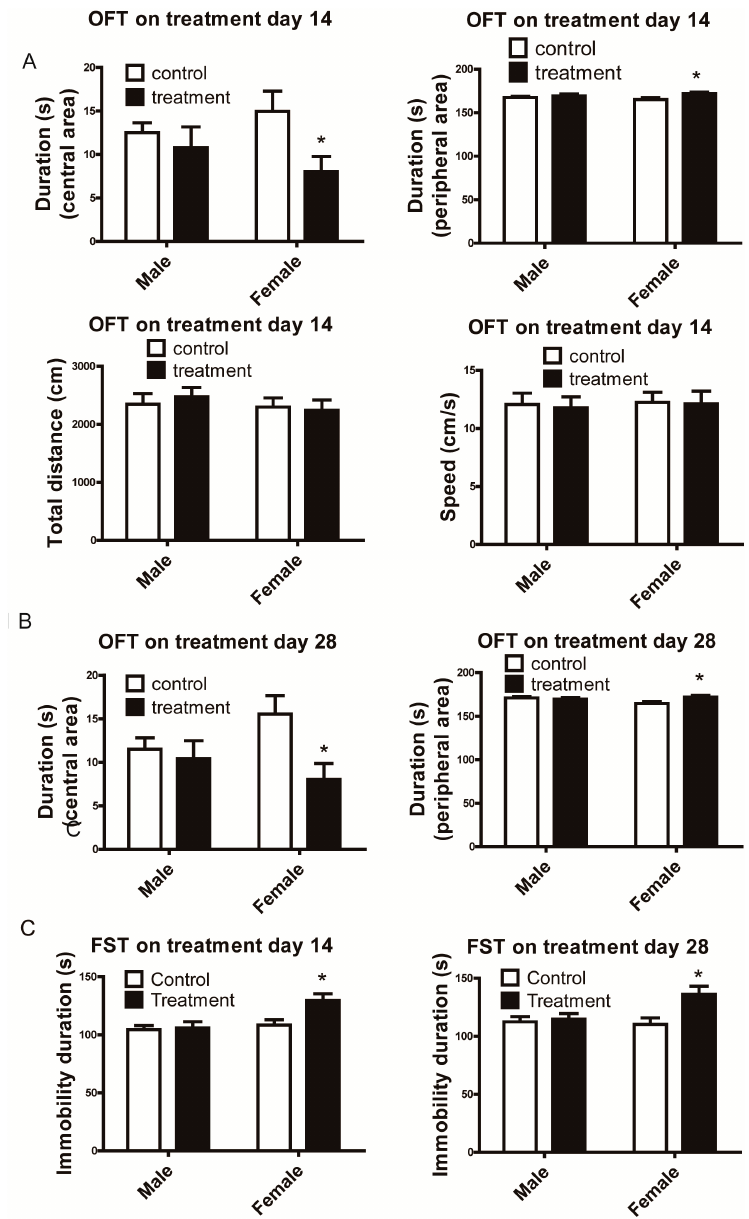
Figure 1. Emotional behavioral tests of mice treated by Al 2 O 3 NPs. ( A ): female mice showed less duration in central zone and increased duration in periphery zone in OFT on treatment day 14, ( B ): On the treatment day 28, results were consistent with day 14, ( C ): female mice showed increased immobile duration in FST on treatment day 14 and 28. * p < 0.05, compared with control of corresponding sex, n = 10.